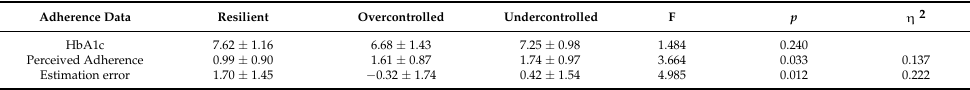
Table 2. Adherence